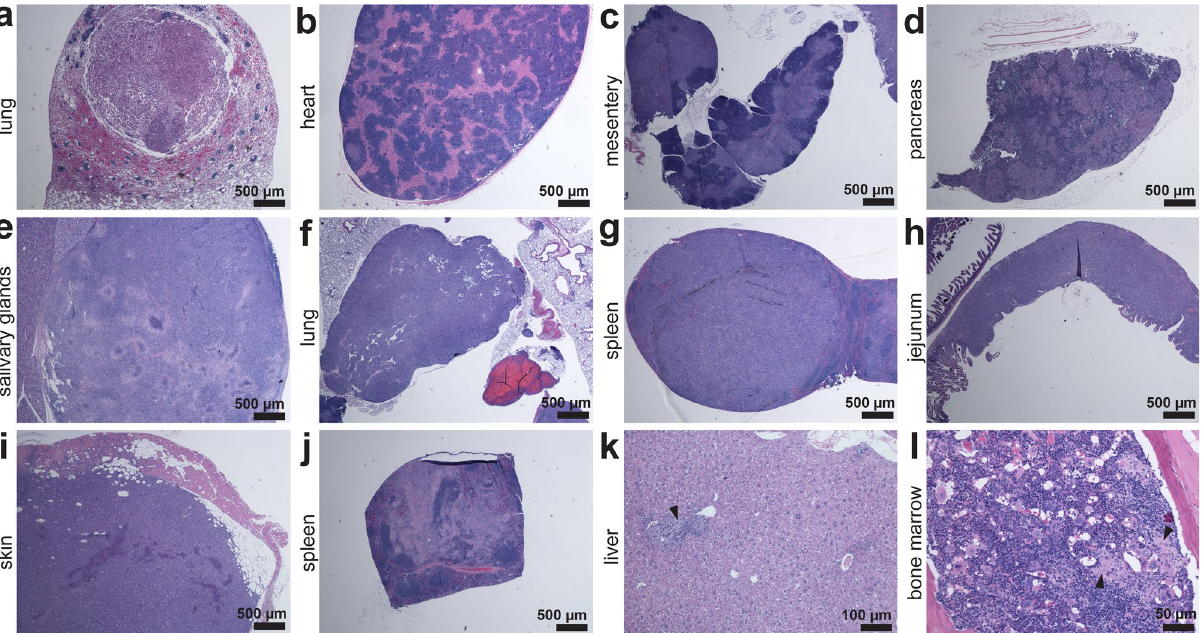
Figure 8. Multiple types of tumors observed in various organs of Lpo del mice. ( a – l ) HE-stained sections of tissue samples from mutant mice. ( a ) Section of a lung tissue exhibiting an apparent carcinoma. ( b – h ) Sections exhibiting a lymphoma adjacent or attached to the following organs or tissues: heart ( b ), mesentery ( c ), pancreas ( d ), salivary glands ( e ), lung ( f ); lymphoma in the spleen ( g ), or in the mucosa of the jejunum ( h ). ( i ) Section of a skin tissue sample exhibiting a pleomorphic sarcoma with giant cells. ( j – l ) Sections exhibiting a histiocytic sarcoma in the spleen ( j ), near a portal vein in the liver (arrowhead, k ) or in the bone marrow (arrowheads, l ). Scale bars are 50 µm ( l ); 100 µm ( k ); 500 µm ( a – j